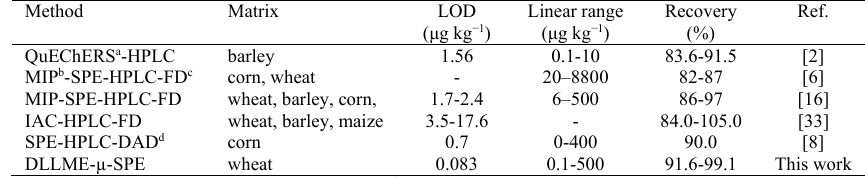
Table 5 Comparison of the proposed method with some previously reported methods for the determination of ZEN.